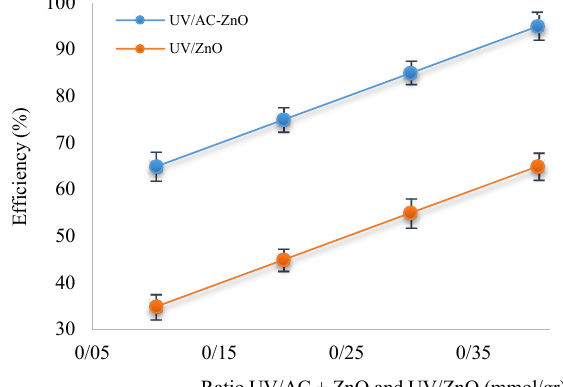
Fig. 9. Effect of changes in Zno alone and ZnO nanoparticles immobilized on activated carbon in removal of acid blue 113 dye (pH: 3, initial dye concentration: 100 mg/l, modified photocatalytic concentration: 100 mg/l, reaction time: 30 minutes)